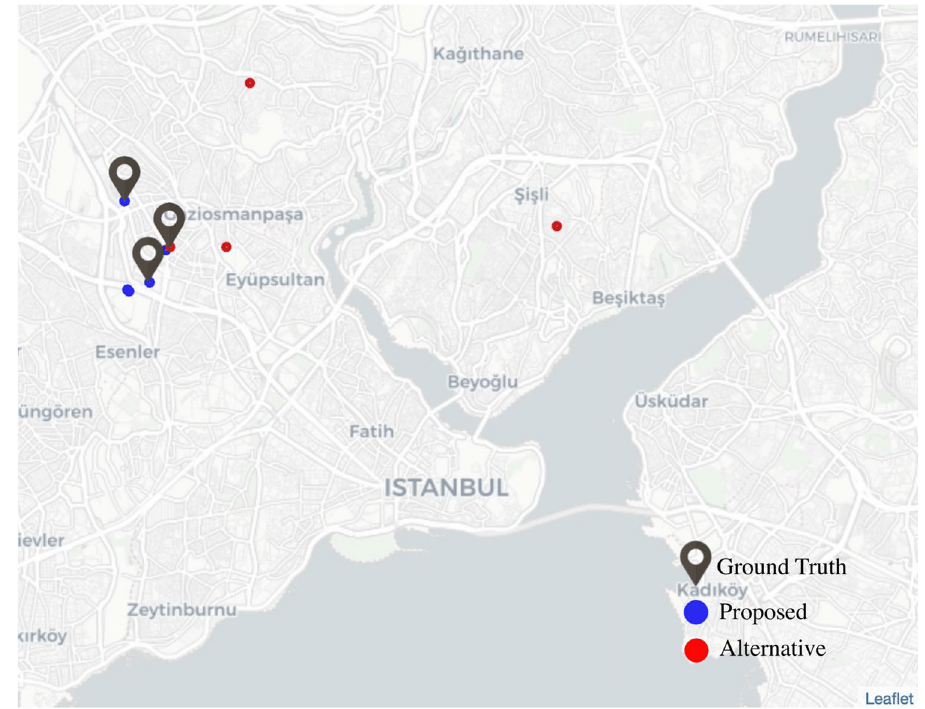
Figure 7. Map visualization of the recommendations by the proposed and alternative